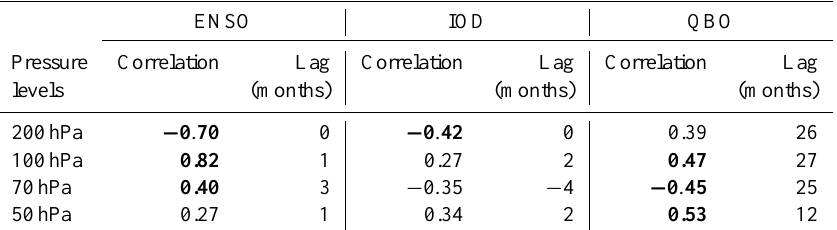
Table 1. Correlation coefficients between ocean–atmospheric climate indices and temperature anomalies at 200, 100, 70, and 50hPa for the period August 2006 to December 2013. The values that are significant at 95% confidence level based on the reduced degree of freedom are bolded.